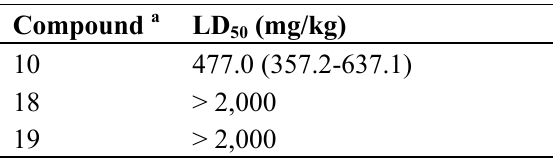
of the compounds. 50